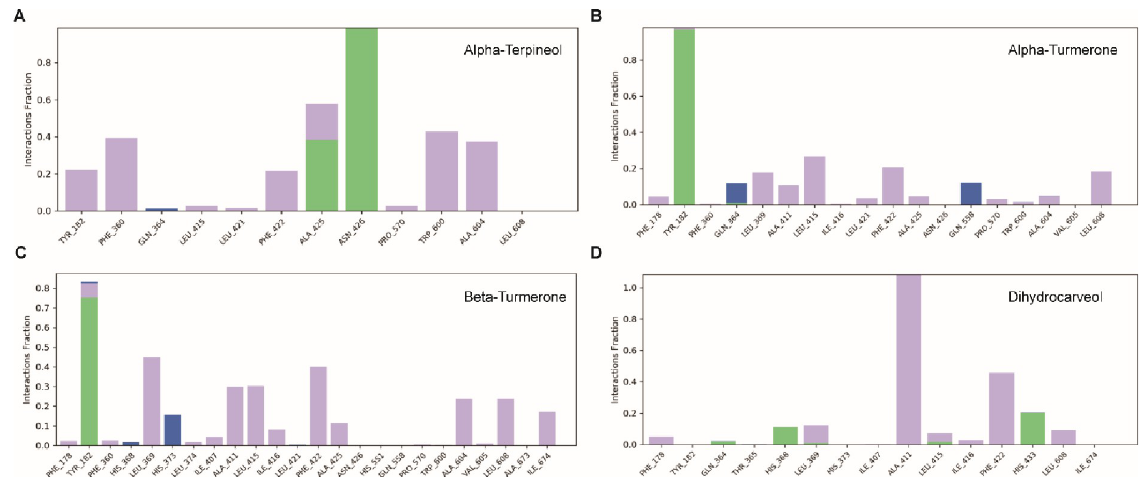
Fig 5. Interaction fraction of amino acids from 5-LOX complex systems involved in ligand recognition during 100 ns MD (A: B: C: D:).